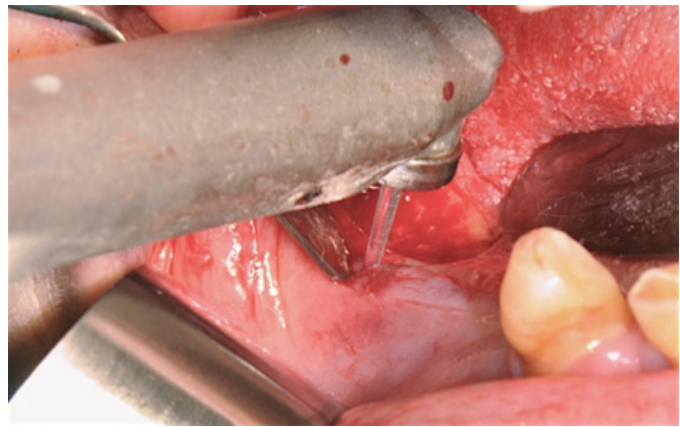
Figure 4. Intraoral intraoperative image of ablative surgery with ER:YAG laser.